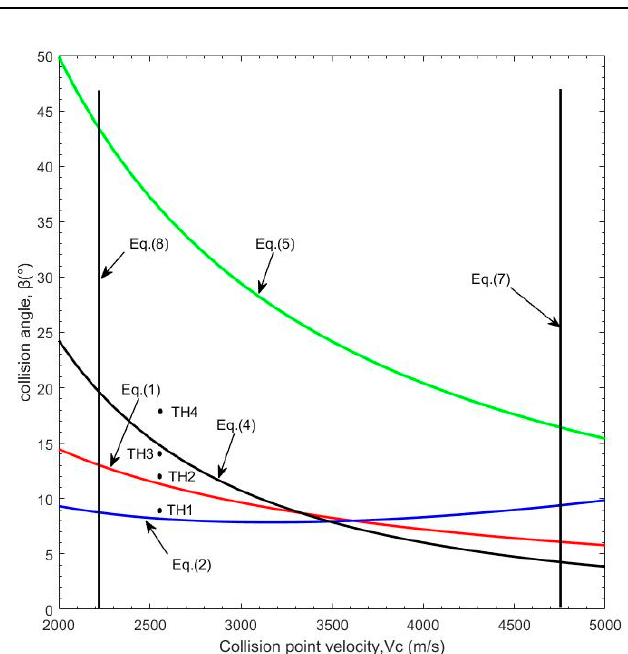
Figure 2. The explosive welding weldability window for the red copper and HNASS calculated using Equations (1)–(8).